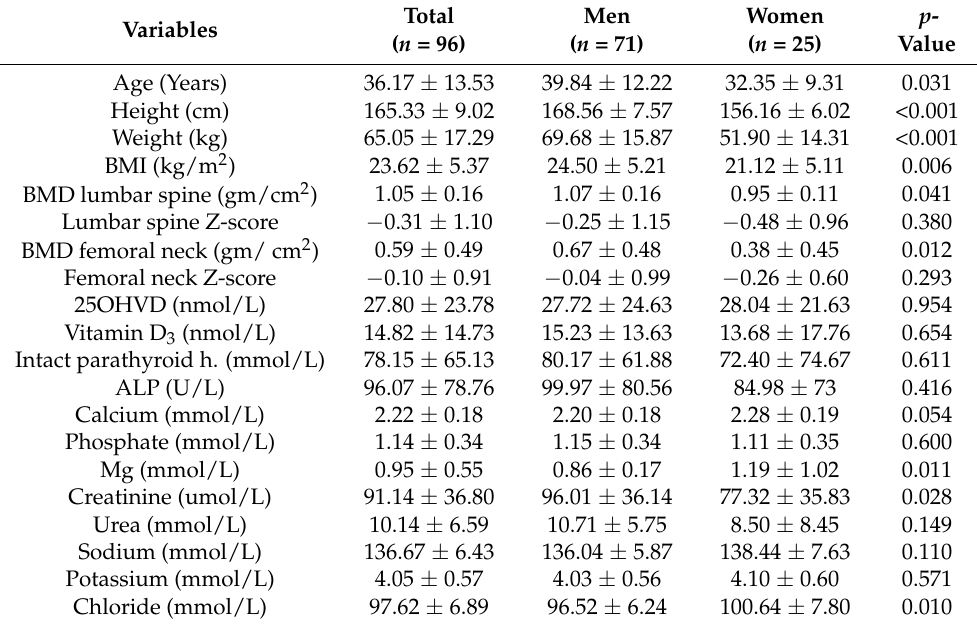
Table 1. Pretransplant characteristics of the study sample.